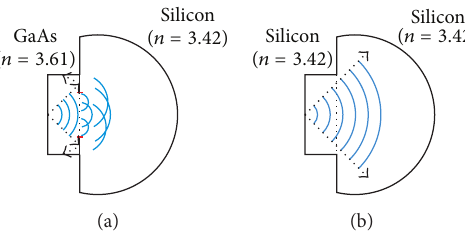
Figure 5: Schematic drawing of the THz wavefront propagation from GaAs substrate (a) and Si substrate (b) in a Si lens. In the case of a refractive index jump between the substrate and the lens a limiting stop aperture appears, leading to additional interference distortions of the THz radiation pattern. The stop aperture size in the case of Si substrate is determined by the lens size. The antenna sits in the center at the leftmost interface.